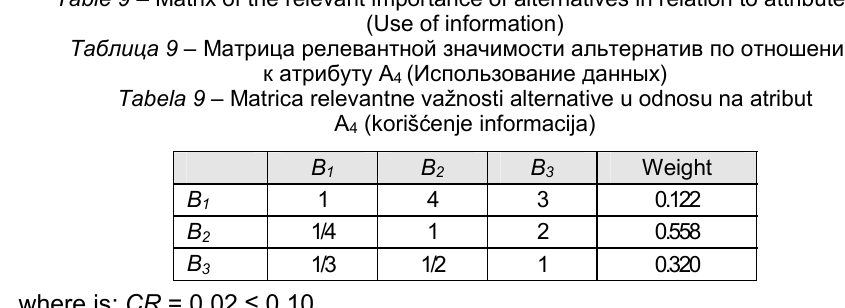
Table 9 – Matrix of the relevant importance of alternatives in relation to attribute A 4 (Use of information) Таблица 9 – Матрица релевантной значимости альтернатив по отношению